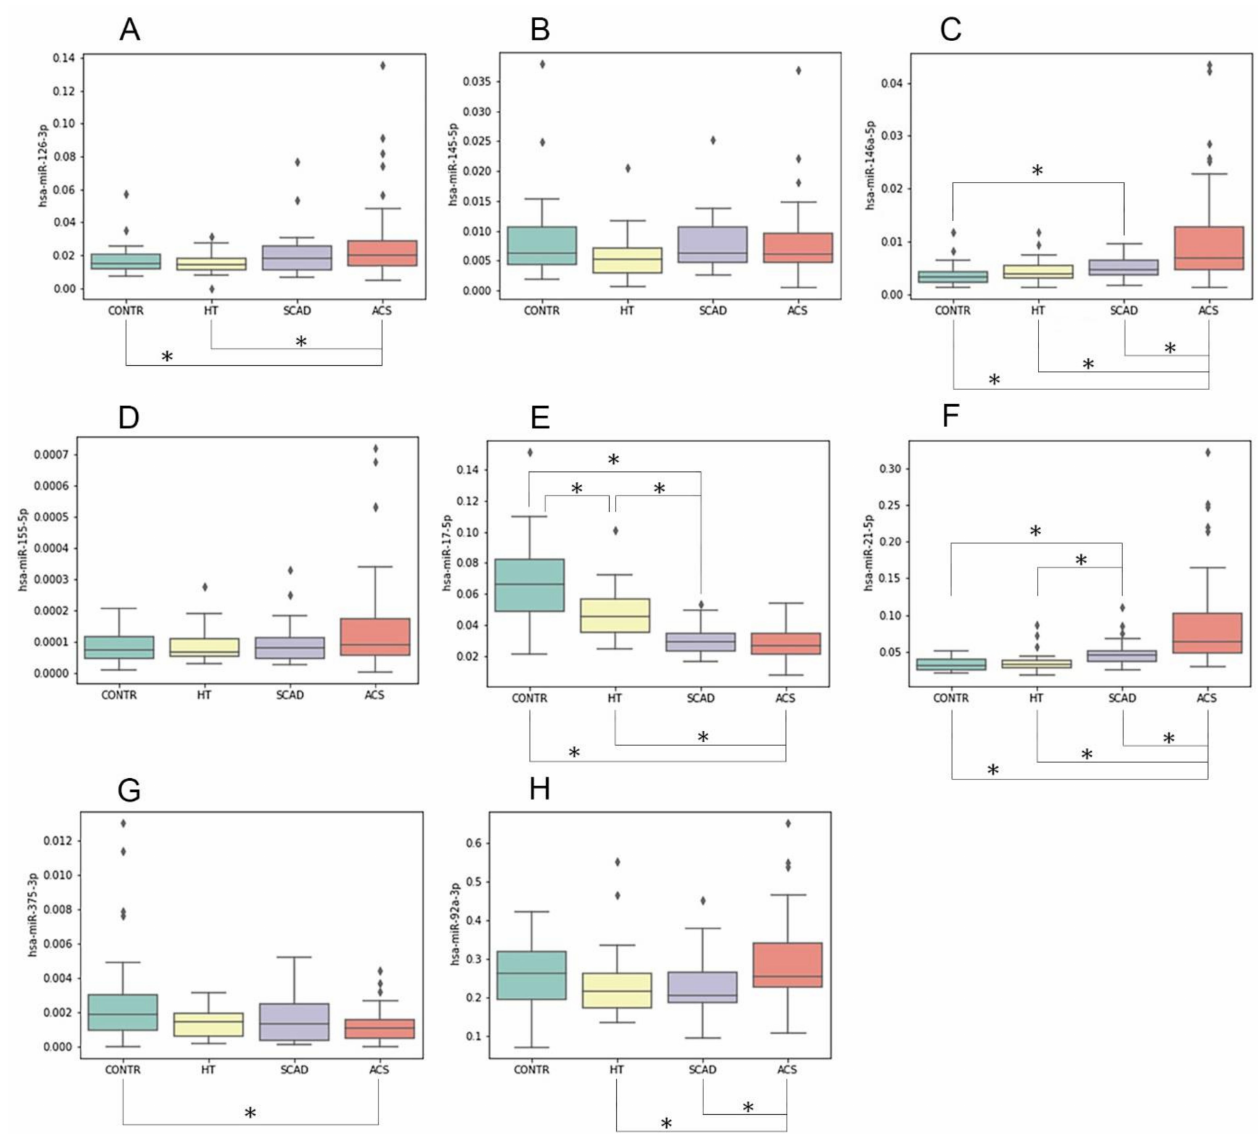
Figure 3. Relative miRNA plasma levels in the study sample groups: ACS, 50 ACS patients; SCAD, 26 patients with stable CAD; HT, 30 hypertensive patients without CAD; CONTR, 30 healthy controls. On the y -axis, relative plasma levels (normalized to miR-16-5p) are shown for miRNAs: miR-126-3p ( A ); miR-145-5p ( B ); miR-146a-5p ( C ); miR-155-5p ( D ); miR-17-5p ( E ); miR-21-5p ( F ); miR-375-3p ( G ); miR-92a-3p ( H ). The boxplots represent median and interquartile ranges (IQRs) in the box, minimum and maximum values in the “whiskers”, and outliers in the dots. Asterisks indicate differences in relative miRNA plasma level in the group pairwise comparisons (Mann–Whitney test, * p <